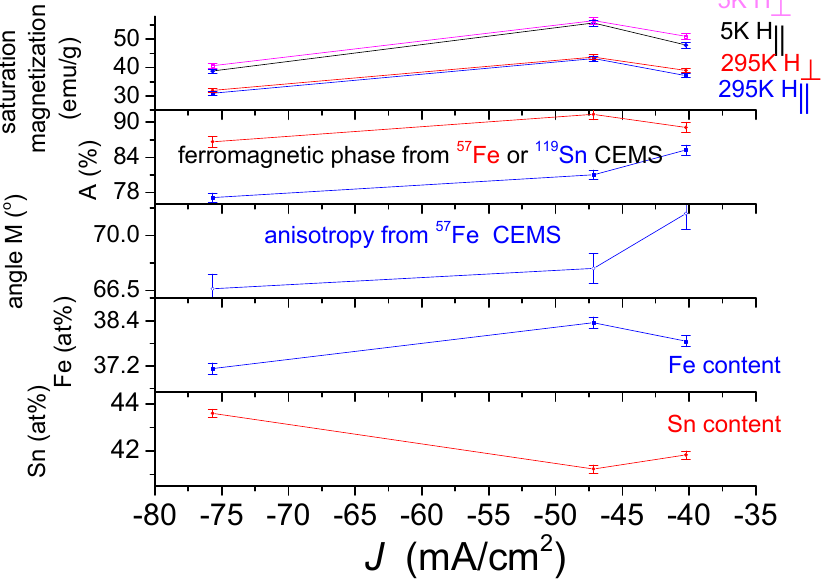
Figure 17. Dependence of saturation magnetization of PP electrodeposited quaternary Sn-Fe-Ni-Co alloy coatings on the current density, together with the current density dependences of the occurrence of ferromagnetic phase detected by 57 Fe and 119 Sn CEMS, direction of average magnetization derived from 57 Fe CEMS, as well as Fe and Sn